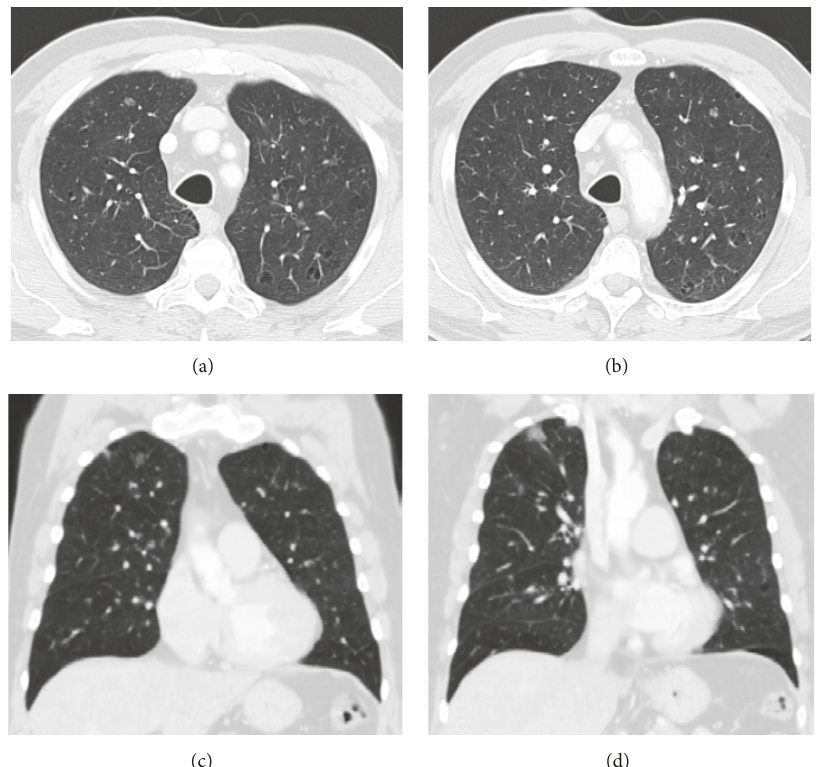
Figure 2: Selected axial and coronal HRCT images on lung windows show bilateral pulmonary cysts. Some of them are rounded and some demonstrate bizarre shapes with multiloculation and internal septations. There are also bilateral ground-glass nodules ranging from 1-2mm up to a few centimeters. The findings are upper lobe predominant and spare the lung bases.